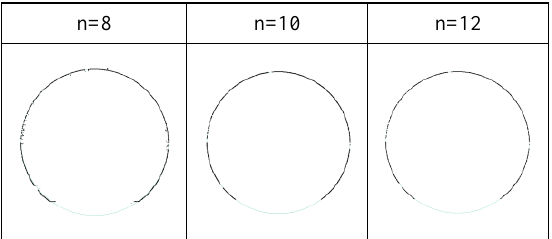
Figure 11 Deformation curve lines